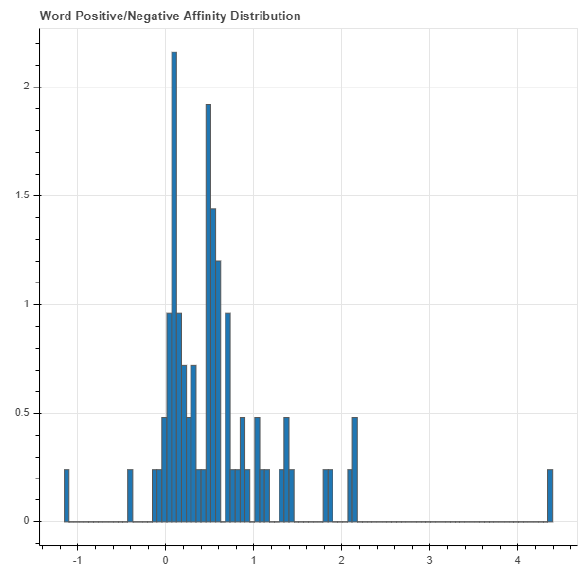
Figure 2. Word positive to negative affinity distribution